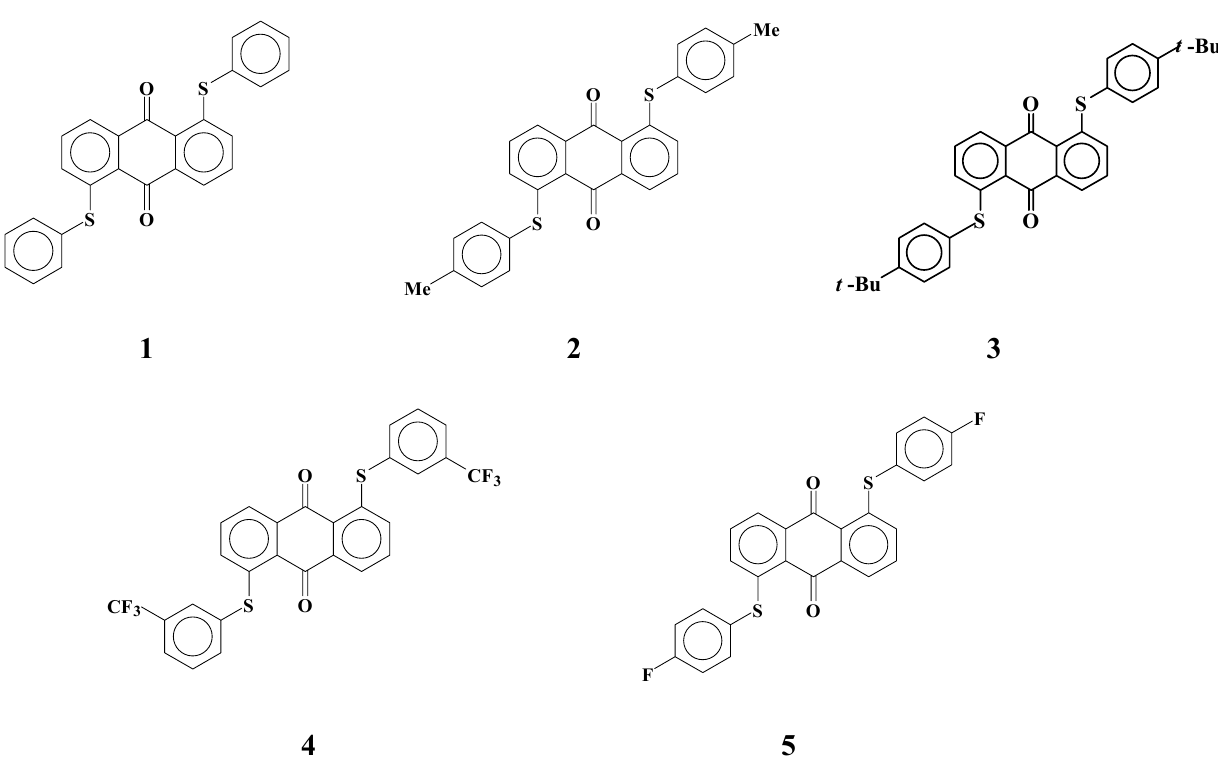
Figure 3. The molecular structures of yellow anthraquinone dichroic dyes with phenylthio groups used in this